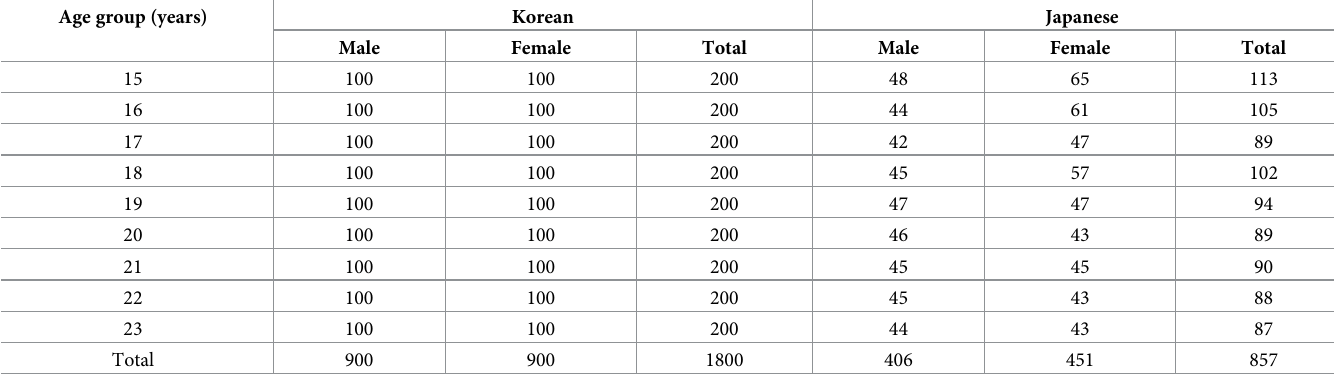
Table 1. Distribution of age and sex of the